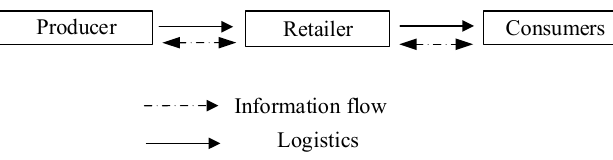
Figure 3. The simplified supply chain model.